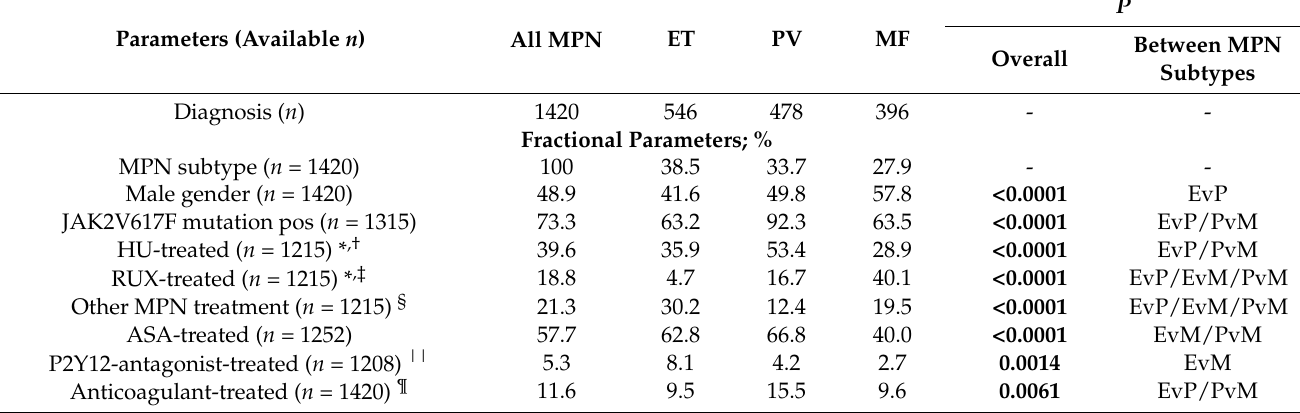
Table 1. Patient characteristics of the total cohort and by MPN